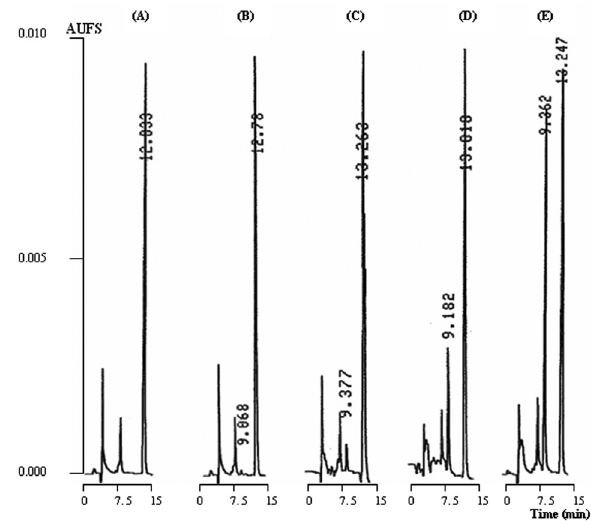
Figure 1 - Chromatographic profile of fluconazole in plasma. Chromato- grams: (A) Blank plasma. (B) Spiked blank plasma extracts Lower limit of detection (0.4 µg mL -1 ); (C) Low standard (2.2 µg mL -1 ) and (E) Medium standard (25.0 µg mL -1 ). (D) Plasma extract of Patient #3 (15.0 µg mL -1 ). Retention times: 9.3 min. (fluconazole) and 13.2 min (carbamazepine, internal